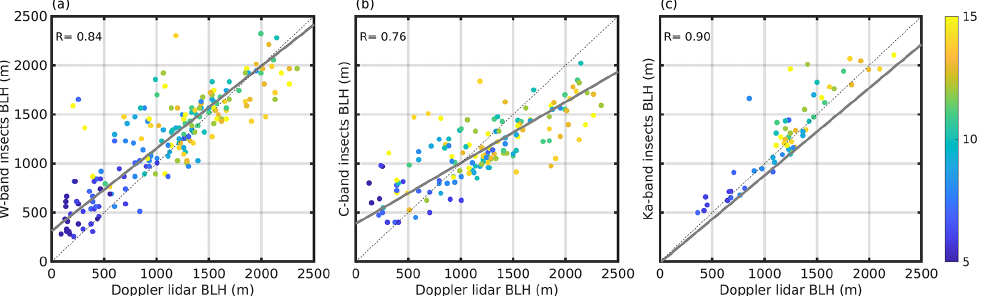
Figure 12. A comparison of the CBLH derived from the HALO Doppler lidar and (a) the W-band, (b) the C-band and (c) the Ka-band radars. Colours represent different hours of the day. Note that only 6d of observations were used for the comparison of the Ka-band and the Doppler